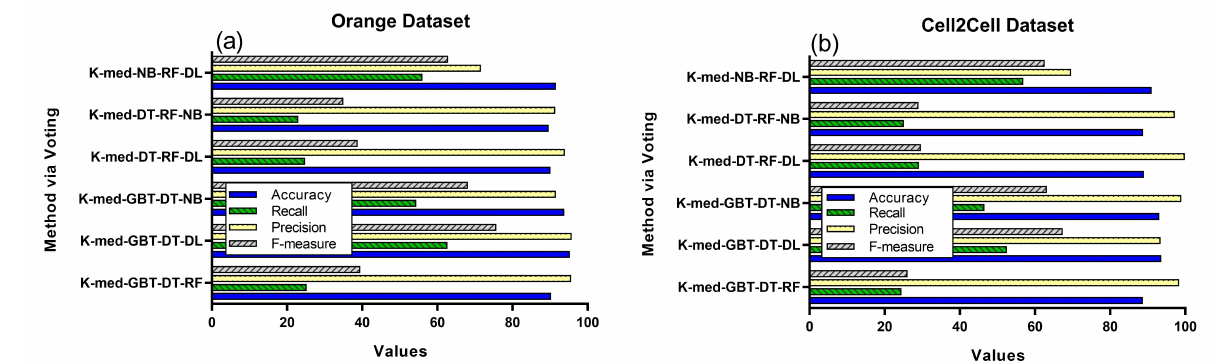
Figure 5. Shows voting-based ensemble classifier results ( a ) Voting-based methods results on the Orange dataset. ( b ) Voting-based methods result on the Cell2Cell